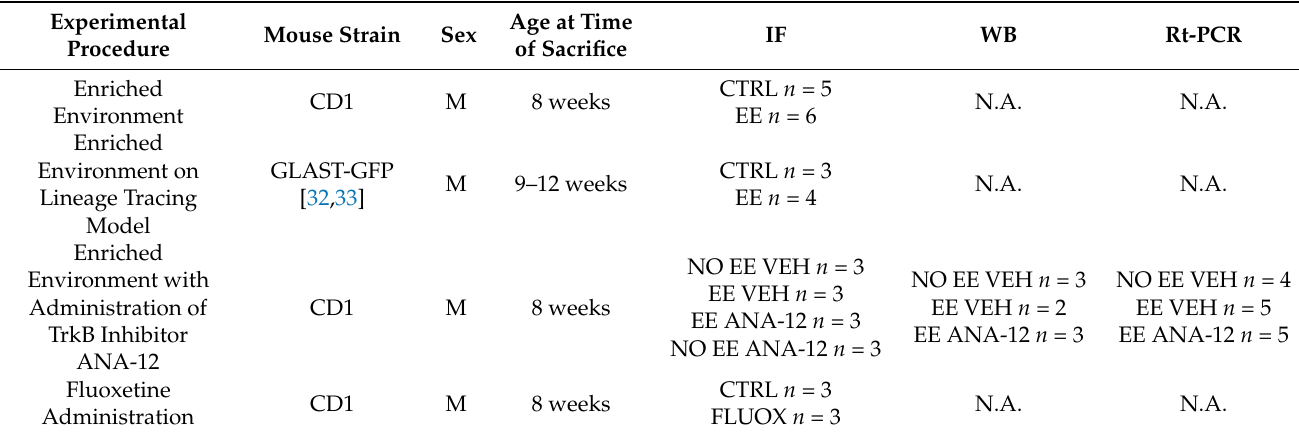
Table 1. Table representing the number of animals used for the different experimental protocols. M = male mice; N.A. = not applicable; IF = immunofluorescence; WB = western blot; RT-PCR = real-time PCR.